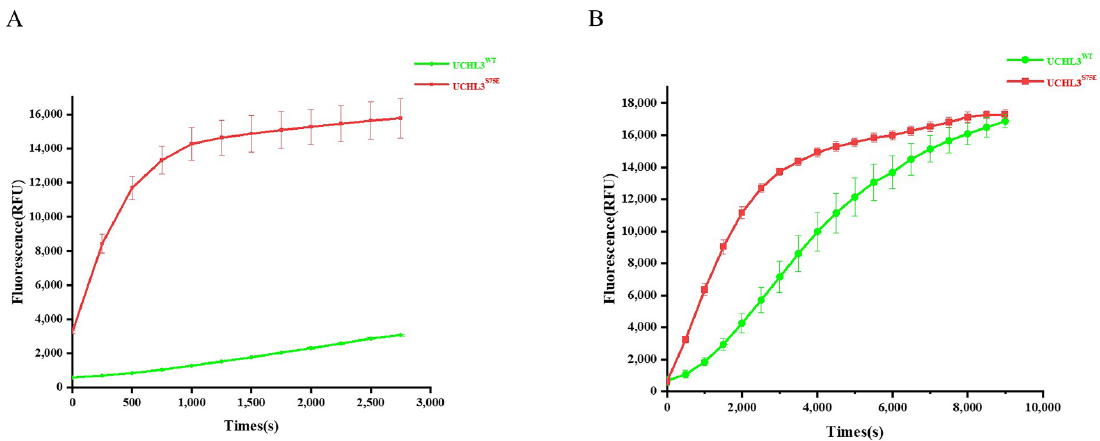
Figure 3. Ub-AMC hydrolysis activity of UCHL3 WT and UCHL3 S75E . UCHL3 and Ub-AMC were used to start the reaction; the fluorescence intensity of Ub-AMC at ex355/em460 was measured and recorded every 250 s for 50min or 500s for150min. The experiment was repeated three times, the average value was calculated, and then ORIGIN was used to process the data. ( A ) Ub-AMC hydrolysis result of 5 nM UCHL3 S75E and 5 nm UCHL3 WT . ( B ) Ub-AMC hydrolysis result of 5 nM UCHL3 S75E and 50 nm UCHL3 WT . 2.6. Cleavage Activity of UCHL3 to Different Types of Ubiquitin Chains in Vitro UCHL3 has been considered to cleave only complexes of monoubiquitin and its small conjugates, such as Ub-AMC, Ub-His, and Ub-Sumo [54]. Moreover, the UCH family of DUBs (UCHL1, UCHL3, UCHL5, and BAP1) is reported to be inactive against di-Ub in all linkage types [54]. Luo et al. found that phosphorylated UCHL3 can cleave polyubiquitin chains in vivo, but in vitro evidence is still lacking [52]. To explore the cleavage preference of UCHL3 for different types of ubiquitin chains and whether phos- phorylation modification gives UCHL3 the ability to cleave ubiquitin chains in vitro, dif- ferent linkages (K6, K11, K27, K48, and K63) of di-Ub were synthesized and tested for their activity of UCHL3 WT and UCHL3 S75E . However, both UCHL3 WT and UCHL3 S75E